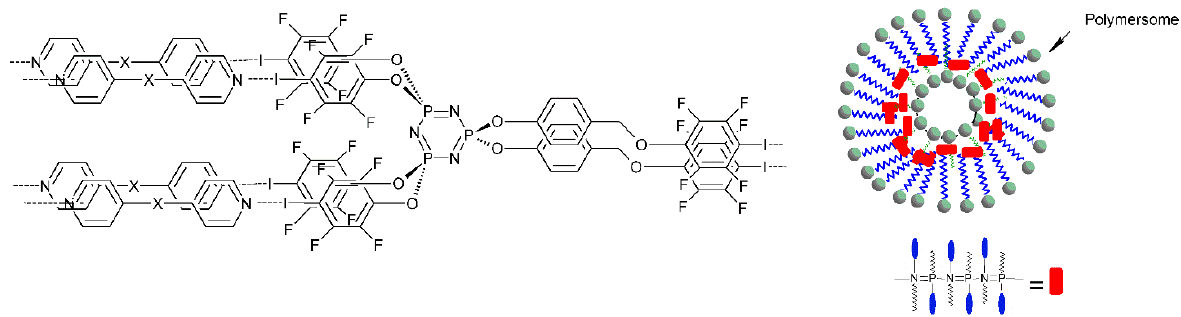
Figure 2. Some supramolecular arrangements of phosphazenes: tapes and polymersomes.